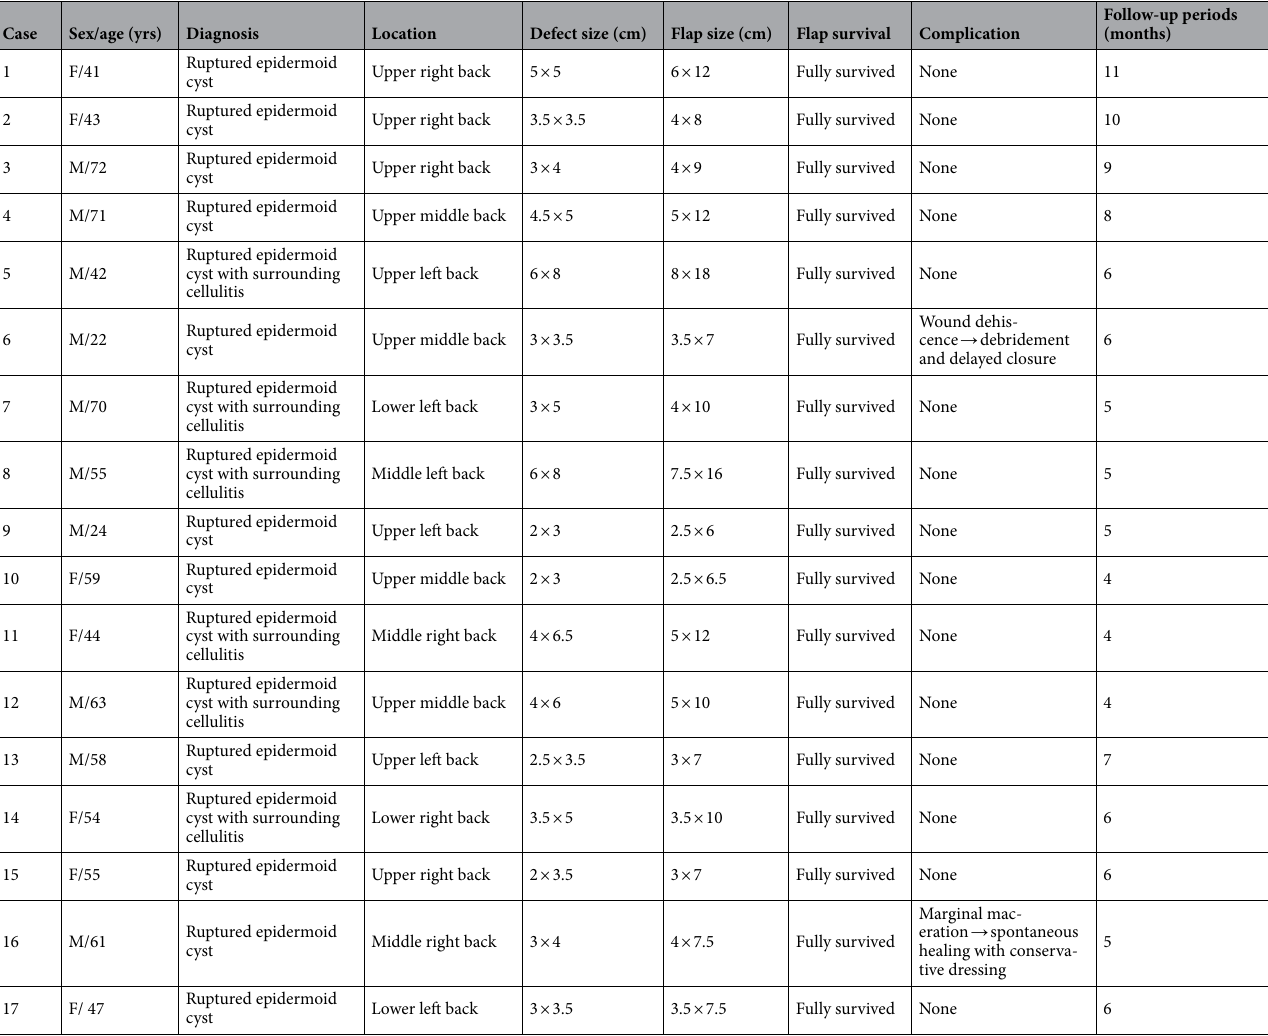
Table 1. Patient characteristics and clinical data. M male, F